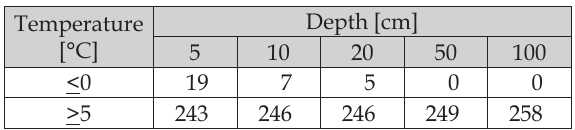
Table 6. Mean annual number of days with soil tem- Table 4. Average monthly, seasonal and annual val -